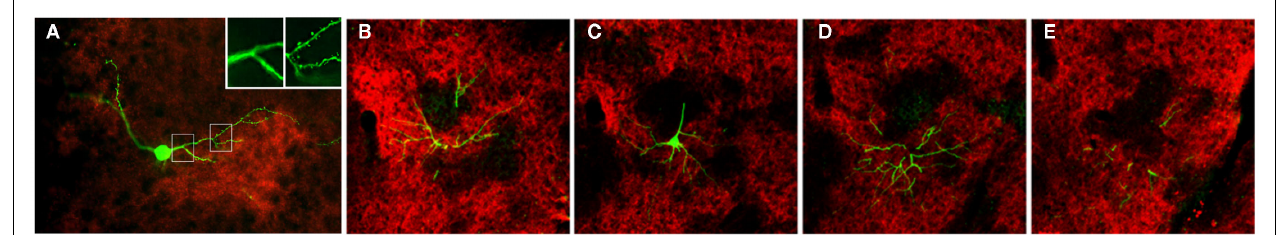
FIGURE 7 | Pyramidal cell dendrites preferentially arborize in either patch or matrix compartments in reeler GRS. (A) Coronal section reacted forVGLUT2 (red), with a Lucifer yellow (LY)-filled neuron (green).This LY-filled neuron has a soma located in a zone of low VGLUT2-ir (presumably equivalent to the OCAM-positive matrix) and many dendrite branches within aVGLUT2-dense patch (presumably equivalent to an OCAM-negative patch).These dendritic portions within VGLUT2-dense patches have spines [arrowheads in (A (cid:2)(cid:2) ) ], but not the portions outside theVGLUT2-dense region (A (cid:2) ) . Insets in (A) [i.e.,